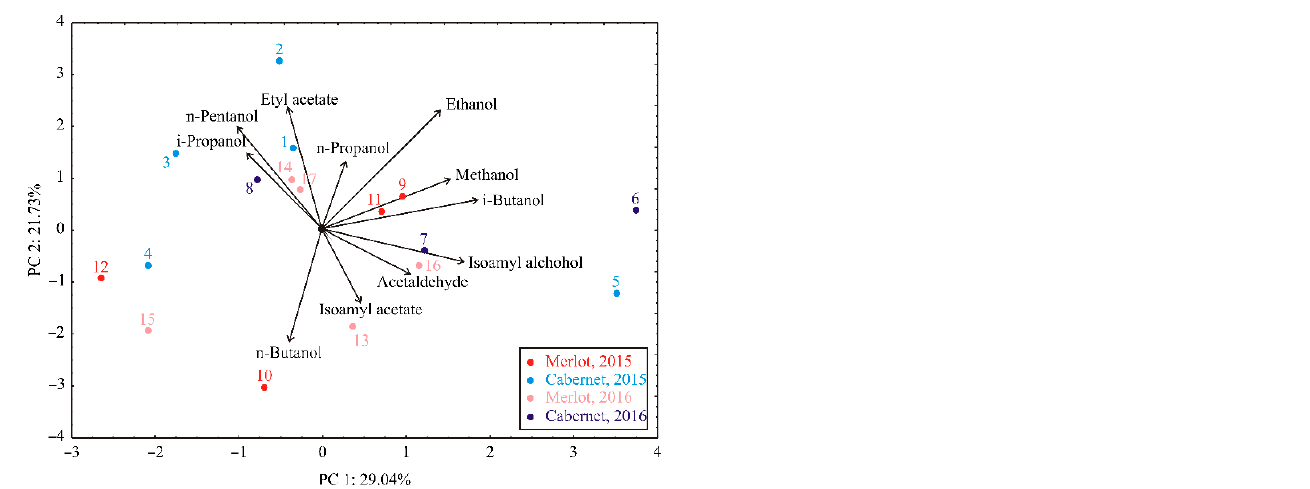
Figure 1. PCA ordination of variables based on component correlations.